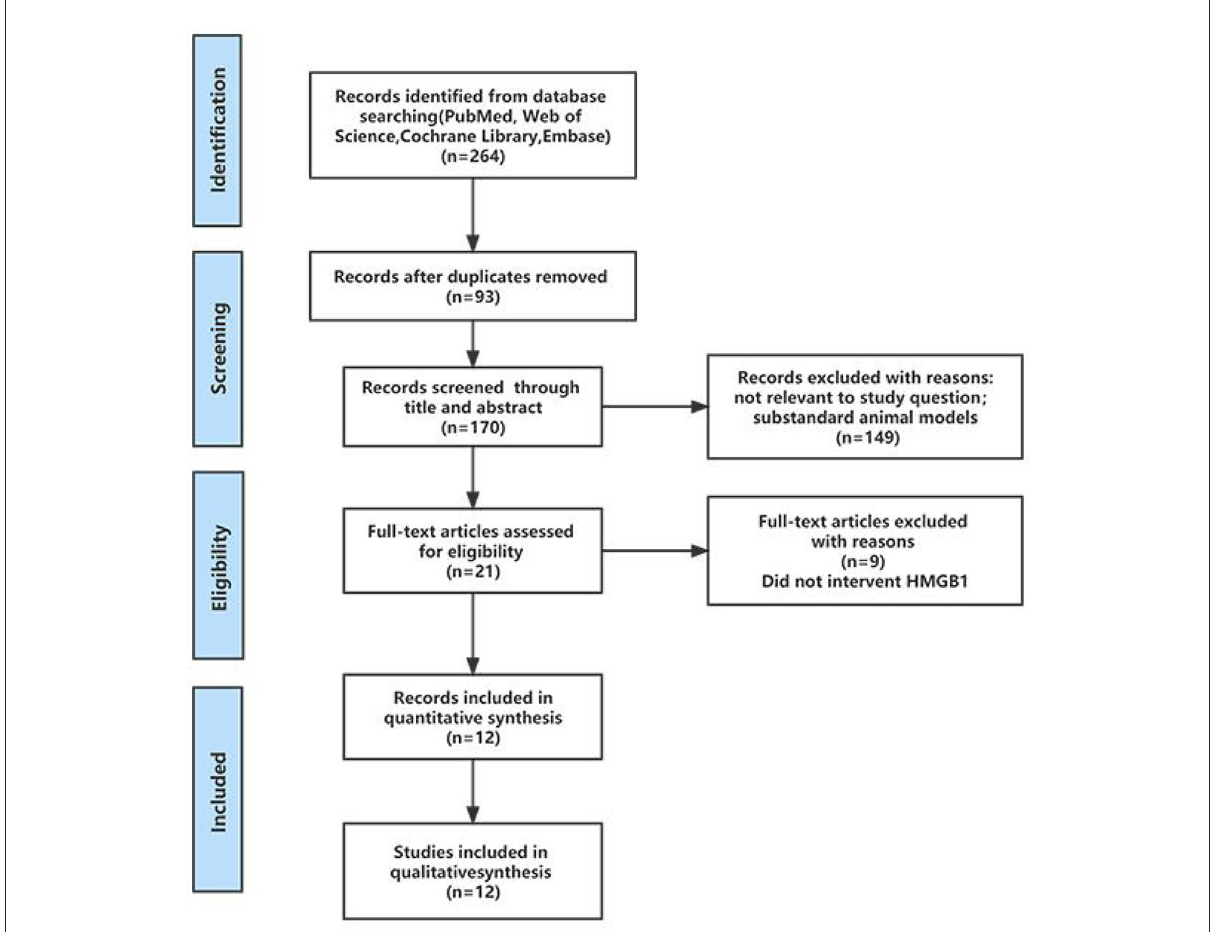
FIGURE1 PRISMA flow diagram to demonstrate the screening process for included studies in this systematic